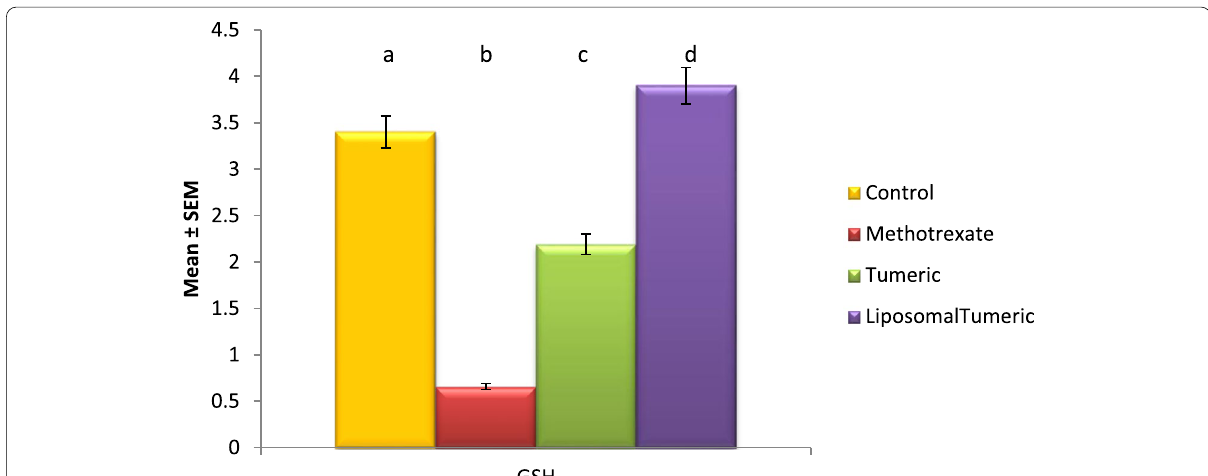
Fig. 2 Impact of turmeric and liposomal turmeric on serum reduced glutathione activity post methotrexate intoxication. Data are expressed as mean SEM ( n 10). p 0.05 value is considered significant. Groups having the same letter are not significantly different from each other, while ± = ≤ those having different letters are significantly different from each other